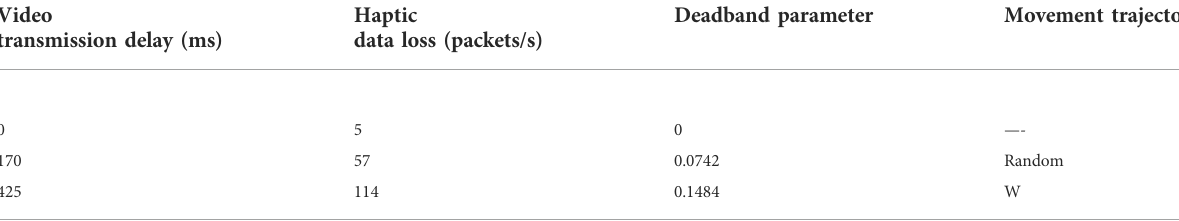
TABLE 3 Value of four quantitative